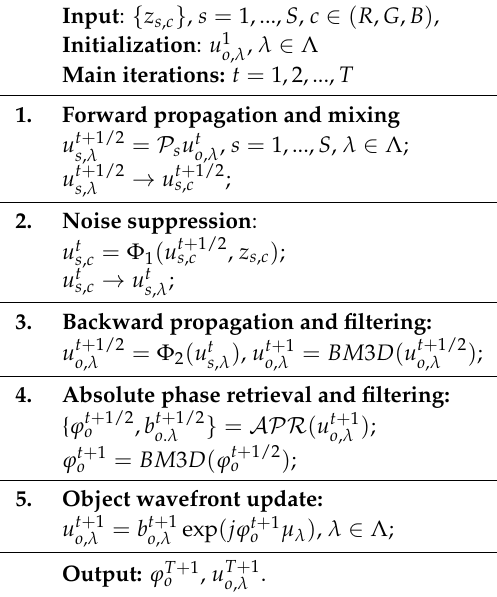
Table 1. Wavelength Multiplexing Absolute Phase Retrieval (WM-APR)